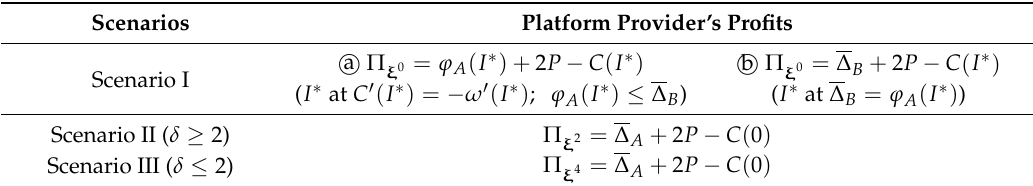
Table 1. Platform provider’s payoffs in